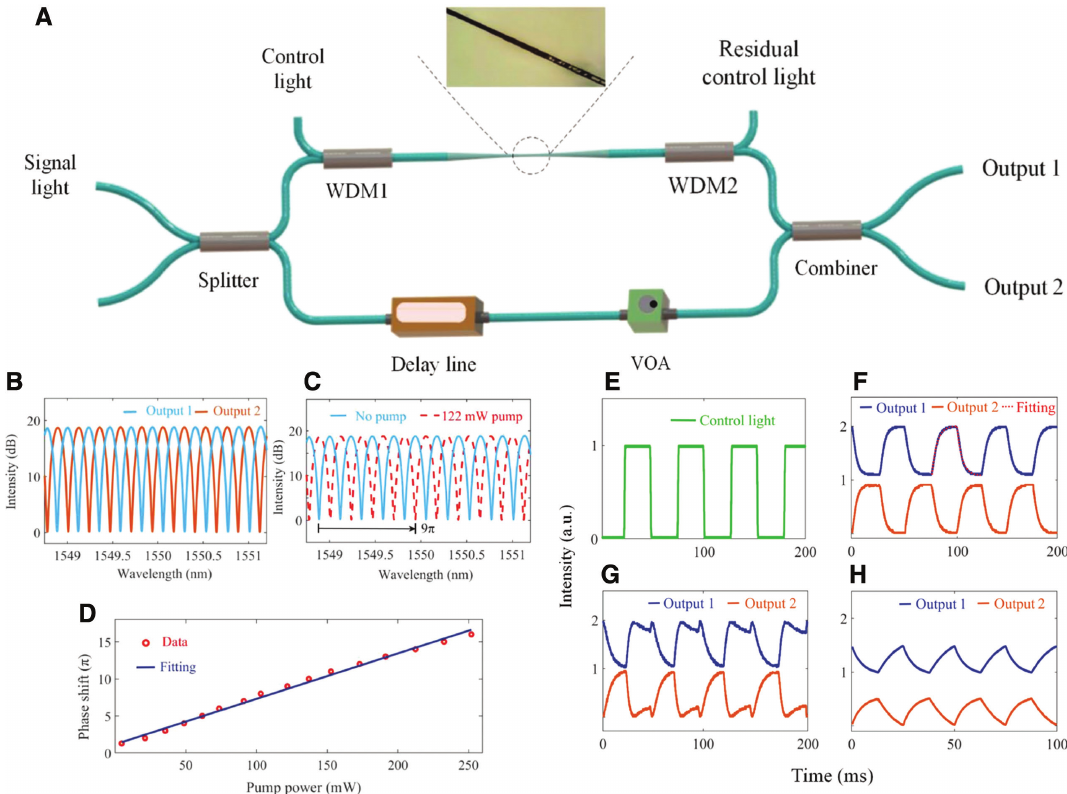
C T (T = F, O, or OH) deposited microfiber. Figure 19: All-optical modulator using the Ti 3 2 x (A) System configuration. (B) Interferometric spectra of Output 1 and Output 2. (C) Measured interference fringes with a pump power of 122 mW at Output 1 (phase shift of 9 π ). (D) Phase shift of the modulator as the 980 nm pump takes different powers. (E) Waveform of the 980 nm pump light. (F) On-off transition of Output 1 and Output 2 (exponential fitting curve is indicated by the red dashed line). (G) Output breaking. (H) Signal waveforms at 40 Hz. Reproduced with permission [280]. Copyright 2019 John Wiley and